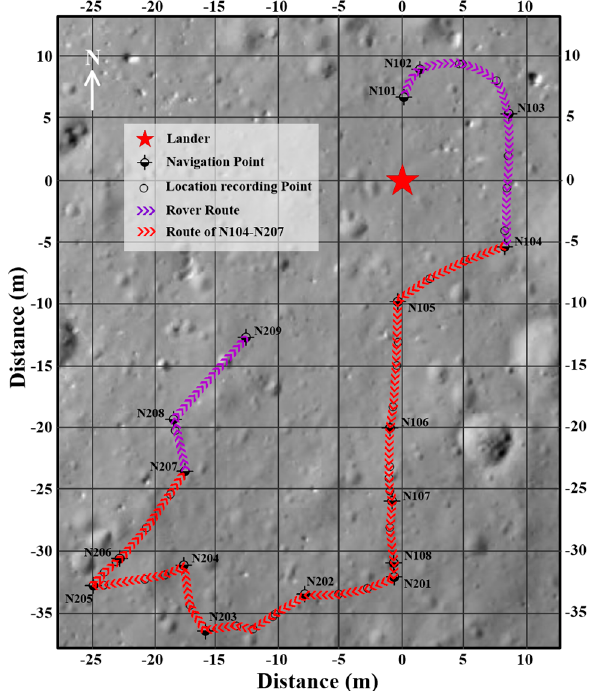
Figure 1. Yutu’s path on the Moon. The background image was taken by the descent camera on the Chang’E-3 (CE-3) lander. The red star shows the landing site. The inset line shows the path (purple line and red line).